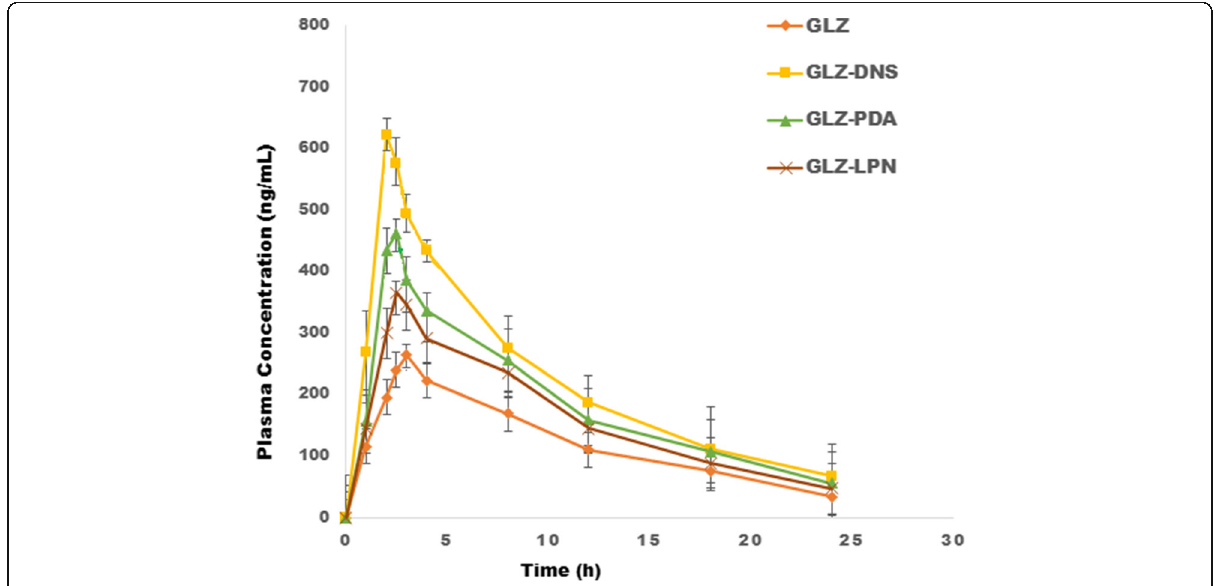
Fig. 9 Mean plasma concentration profiles of GLZ, GLZ – DNS, GLZ – PDA, and GLZ – LPN